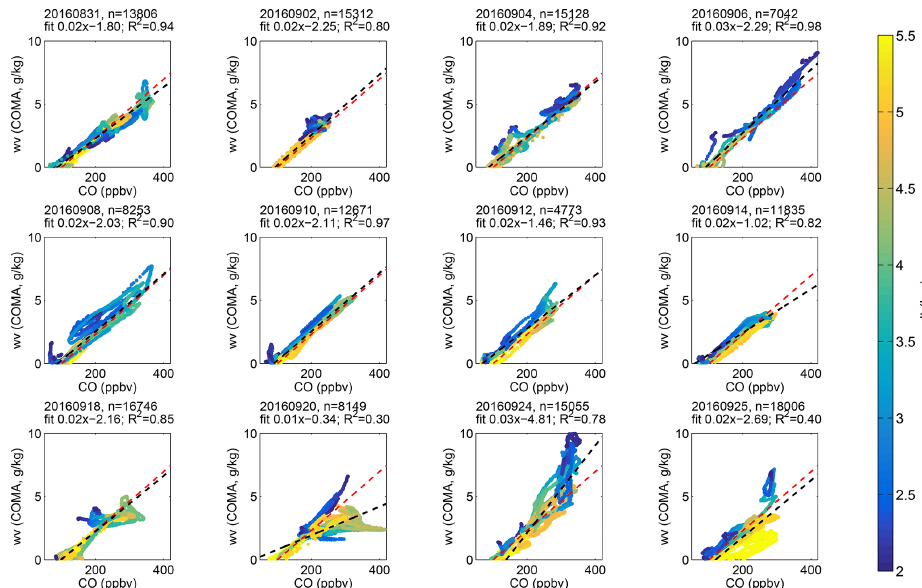
Figure 3. ORACLES-2016 specific humidity versus CO, by flight. Here we show only altitudes substantially above the planetary boundary layer ( > 2km), so as to highlight the correlations at plume level. Dashed black lines show the total least-squares fit to each individual flight ( z > 2km), and the red line shows the fit through all flights combined. All correlation coefficients are significant to two decimal points ( p < 0 . 01). Table 3. Correlations between free tropospheric CO and q ( z > 2km) from in situ instruments as shown in Fig. 3 and correlations between AOD and CWV ( z > 1 . 3km) from 4STAR as shown in Fig. 5, by flight for ORACLES 2016. All correlations are significant to p < 0 . 001. Note that the different altitude limits are due to different methodologies. The terms “routine” and “opportunity” indicate whether the flights were along the northwest diagonal or near the coast (Sect.